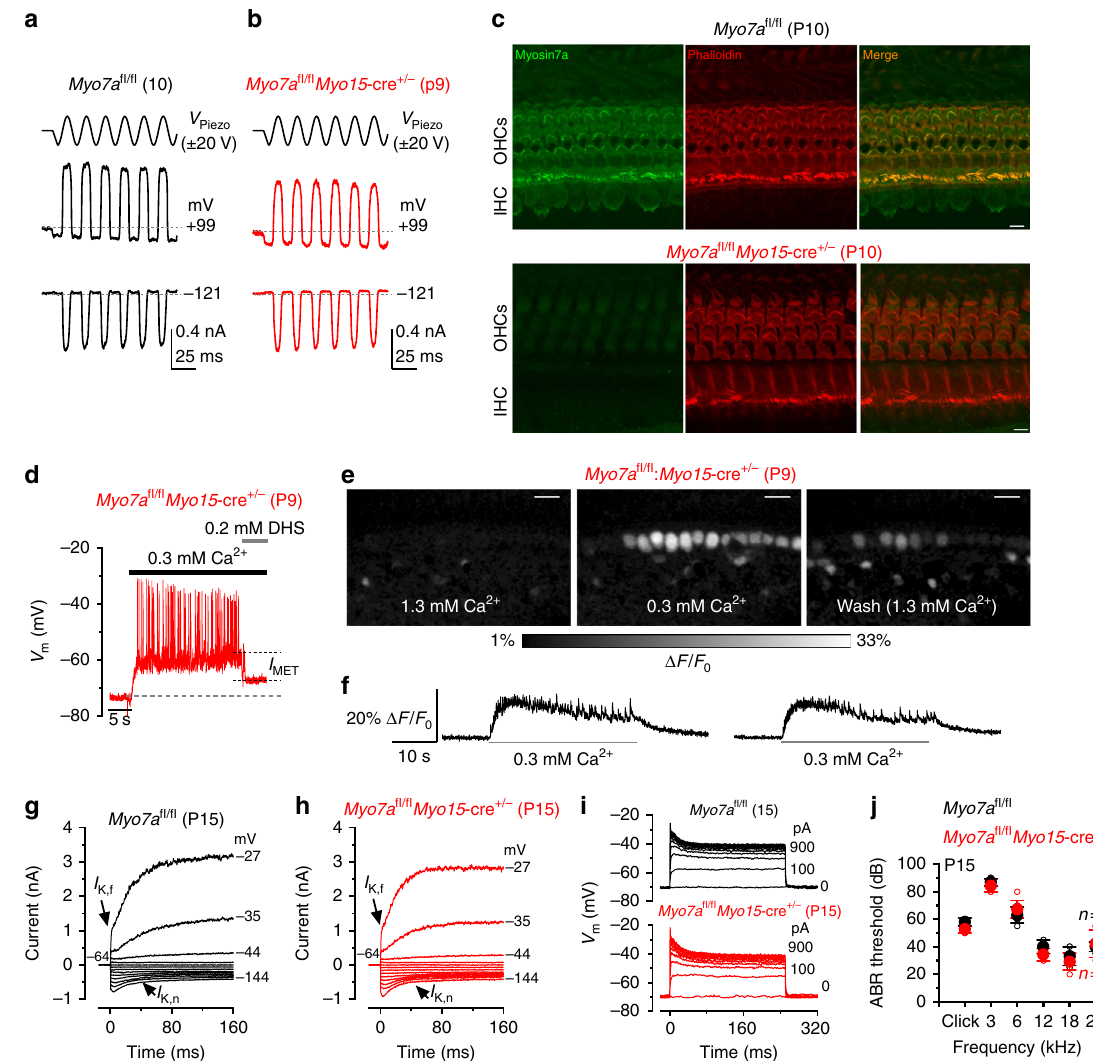
Fig. 4 IHCs from Myo7a fl / fl Myo15 -cre + /- conditional knockout mice acquire their mature phenotype. a , b MET currents from IHCs of control Myo7a fl / fl (left, P10) and knockout Myo7a fl / fl Myo15 -cre + /- (right, P9) mice. The experimental protocol is as in Fig. 2. c Cochlear whole mount preparations from P10 Myo7a fl / fl (control, upper panel) and Myo7a fl / fl Myo15- cre + /- (lower panel) mice, immunostained for Myo7a (green) and for F-actin with phalloidin (red). Myo7a is detected in both OHCs and IHCs in the Myo7a fl / fl mouse, but not in the Myo7a fl / fl Myo15- cre + /- mouse (but see also Supplementary Fig. 4 for one example of normal hair cell Myo7a labeling in a P10 Myo7a fl / fl Myo15- cre + /- mouse). Scale bars, 5 µ m. d IHC voltage response recorded during the superfusion of 0.3 mM Ca 2 + alone and together with the MET channel blocker DHS (0.2 mM) in a Myo7a fl / fl Myo15- cre + /- mouse. The MET depolarizing current substantially contributes to the IHC membrane potential. e Images showing relative fl uo-4 fl uorescence changes ( Δ F / F 0 ) before (left) during (middle) and after (right) application of an extracellular solution containing 0.3 mM Ca 2 + . Images were obtained as maximal back projection (200 frames, 6.6 s). Scale bar, 15 µ m. f Representative Δ F / F 0 traces from two IHCs (from images in panel e ) during bath application of 0.3 mM Ca 2 + . Traces are computed as pixel averages of regions of interest centered on IHCs. Ca 2 + spikes are evident in IHCs; however, the relative long fl uorescence decay time constant of the Ca 2 + signal, prevents the isolation of single APs during high-frequency bursting. g , h Current responses in post-hearing IHCs (P15) from control ( g ) and Myo7a fl / fl Myo15- cre + /- ( h ) mice. Note that both I K,f and I K,n are present in IHCs from both genotypes. Voltage protocol as in Fig. 3a. i Voltage responses recorded from P15 IHCs of control Myo7a fl / fl (top panel) and Myo7a fl / fl Myo15 -cre + /- (lower panel) P15 IHCs (protocol as in Fig. 3c). Panel ( g , j : Myo7a fl / fl ) and ( b , j : Myo7a fl / fl Myo15 -cre + /- ) are representative recordings from 9 IHCs (4 mice) and 8 IHCs (4 mice), respectively. j Mean ABR thresholds ( ± SD) for clicks and frequency-speci fi c pure tone stimulation from 3 Hz to 24 kHz obtained from control Myo7a fl / fl